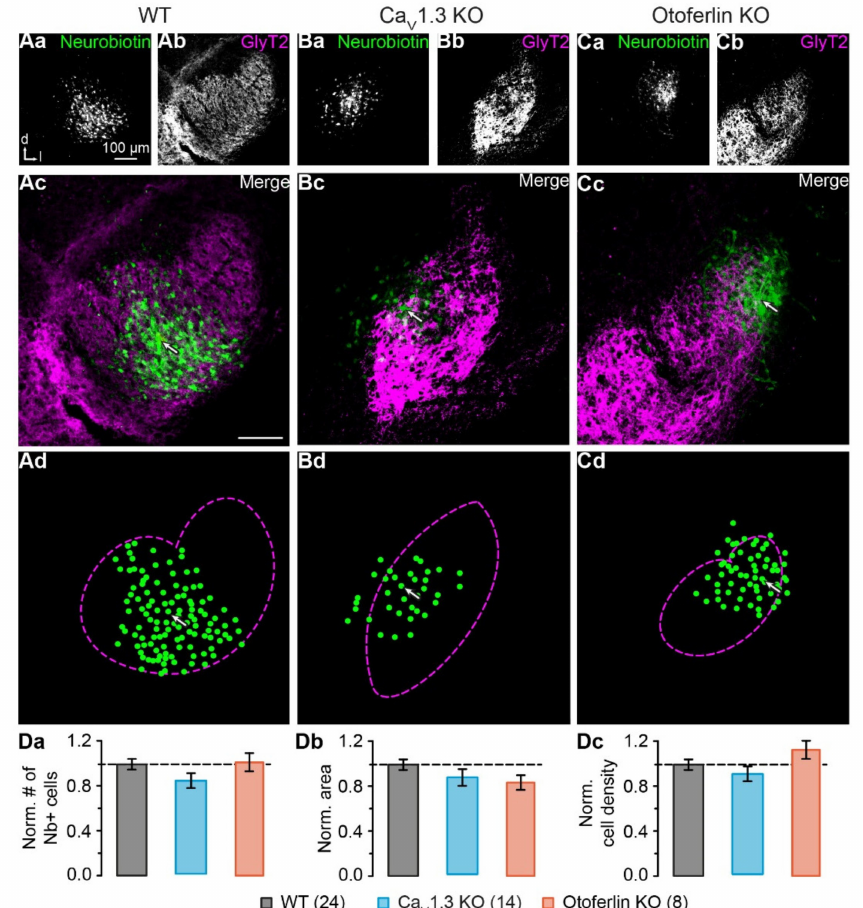
Figure 3. Reconstruction of LSO astrocyte networks. ( A – C ), tracer-coupled networks of the WT, Ca V 1.3 KO, and otoferlin KO mice. The tracer neurobiotin di ff used from the patch-clamped astrocyte into coupled cells ( Aa – Ac , Ba – Bc , Ca – Cc ). Immunohistochemical labeling for glycine transporter (GlyT) 2 highlighted the LSO ( Ab , Bb , Cb ) and allowed the localization of the network within the nucleus ( Ac , Bb , Cc ). Cells with fluorescence intensity of at least 1.75-fold background intensity were transferred to a schematized representation and are displayed by green dots ( Ad , Bb , Cd ). The dotted magenta lines indicate the LSO border as derived from GlyT2 labeling ( Ab , Bb , Cb ). The arrows in ( Ac , Ad , Bc , Bd , Cc , Cd ) mark the patched cell. ( D ) , network properties. Values were normalized to the WT data, indicated with the dashed line. There were no di ff erences between the number of coupled cells ( Da ), network area ( Db ), or density of coupled cells ( Dc ). The WT data ( Aa – Ad ) were part of [9]. Panel ( Aa – Ac ) was reused from that publication. ( Da – Dc ) show mean ± SD. Number of slices is given in